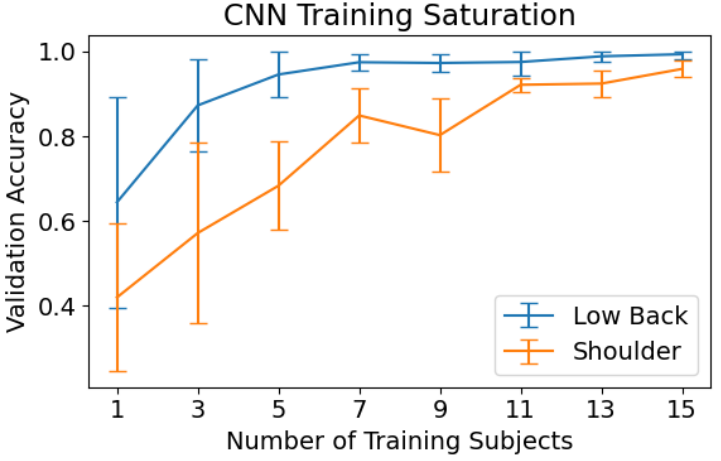
Figure 6. CNN performance as a function of training set size. The CNN was trained on a random subset of subjects from the training set of a 5-fold cross validation split and tested on a constant held- out validation set. The mean accuracy ± 95% CI is shown for various training set sizes (displayed as the number of subjects). This is shown for both the low back (blue) and shoulder (orange) classification tasks. Only records from one camera angle for each exercise were used in this